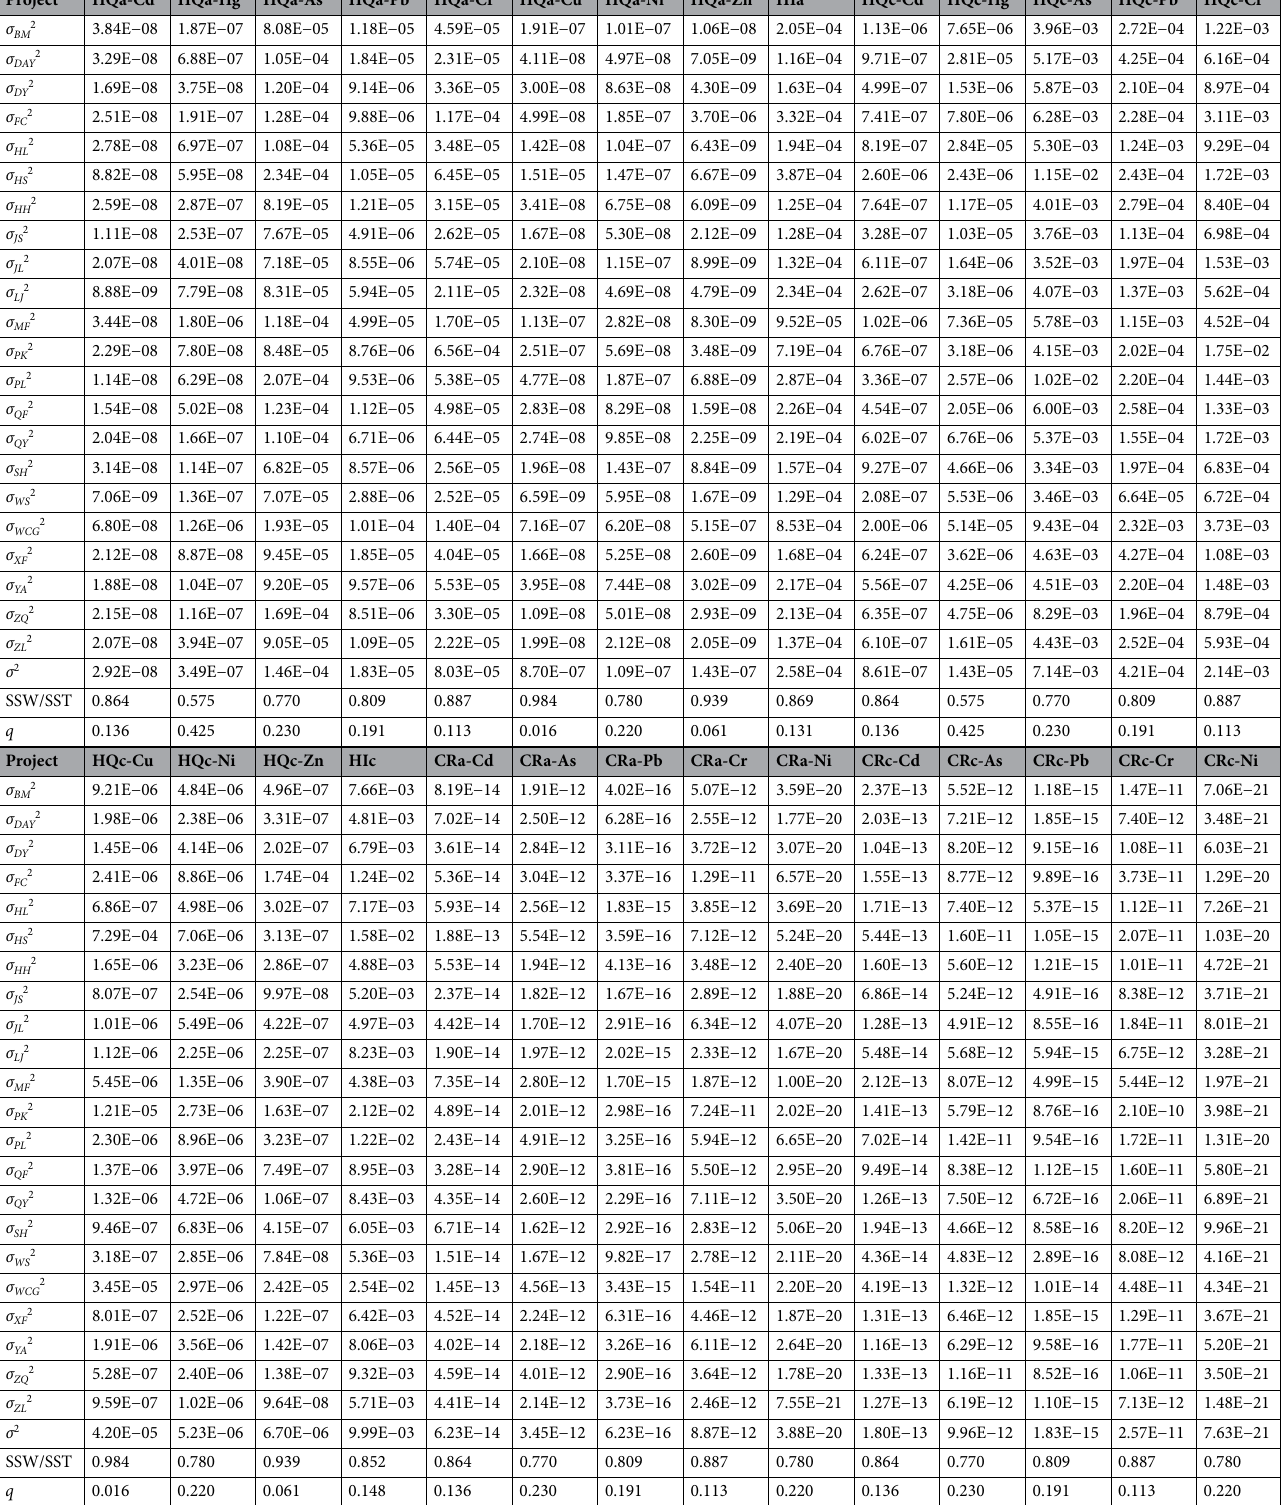
Table 4. Analysis of the spatial differentiation characteristics health risk of HMs based on geographic